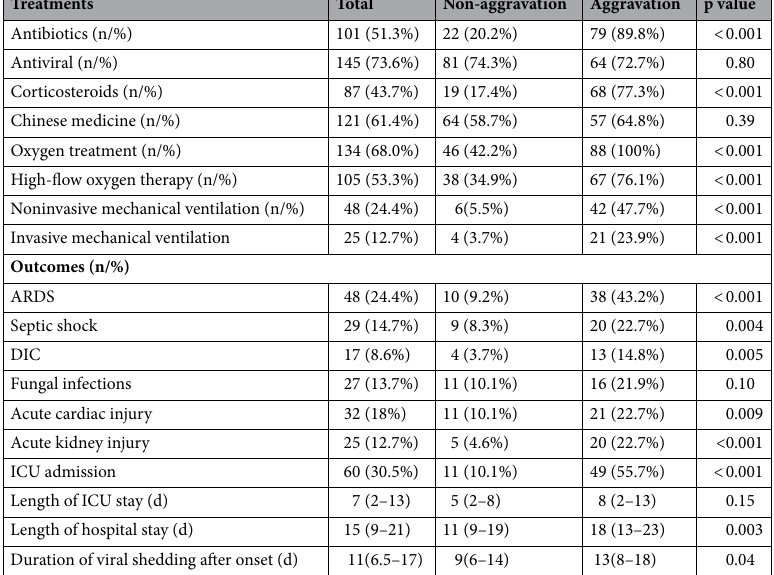
Table 6. Treatment and outcome of COVID-19 patients. Data are median (IQR), n (%).